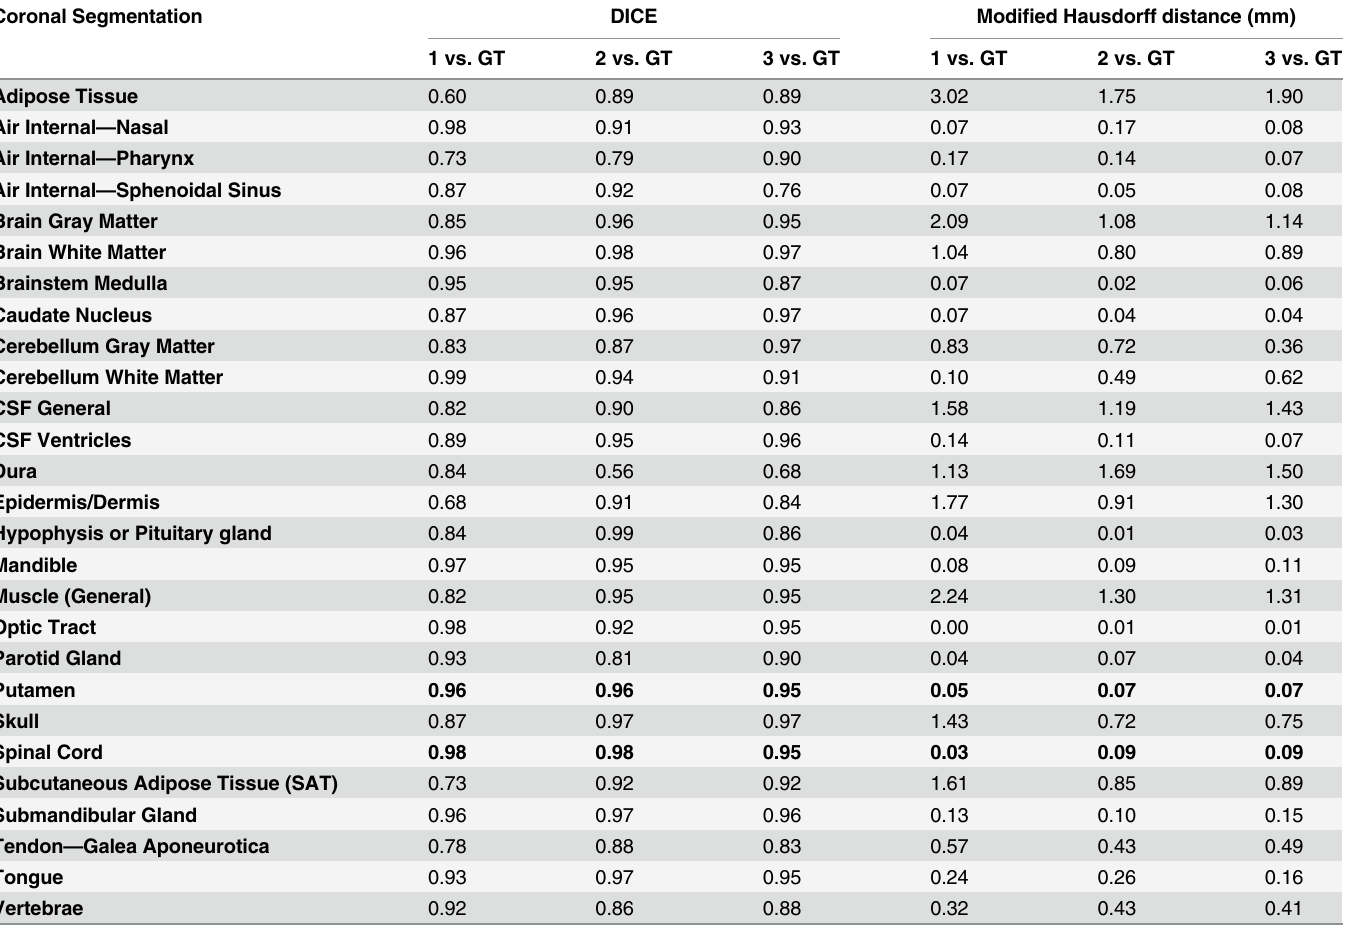
Table 4. Inter-operator variability across structures assessed on the coronal